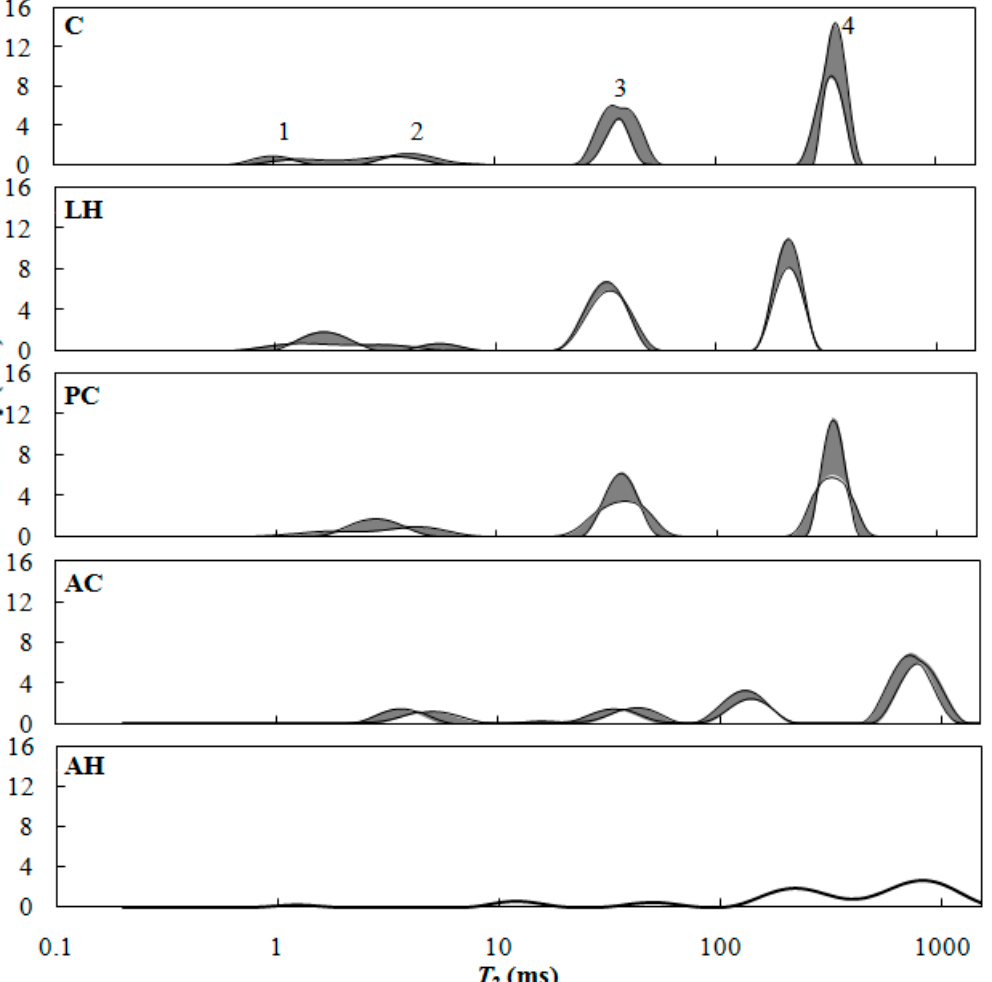
Figure 2. Continuous T 2 (spin–spin) distributions for control wood (C), wood with low hemicelluloses (LH), pyridine-treated wood (PC), acetylated wood (AC), and acetylated wood with low hemicelluloses (AH). Gray filled areas represent mean values including standard deviation.